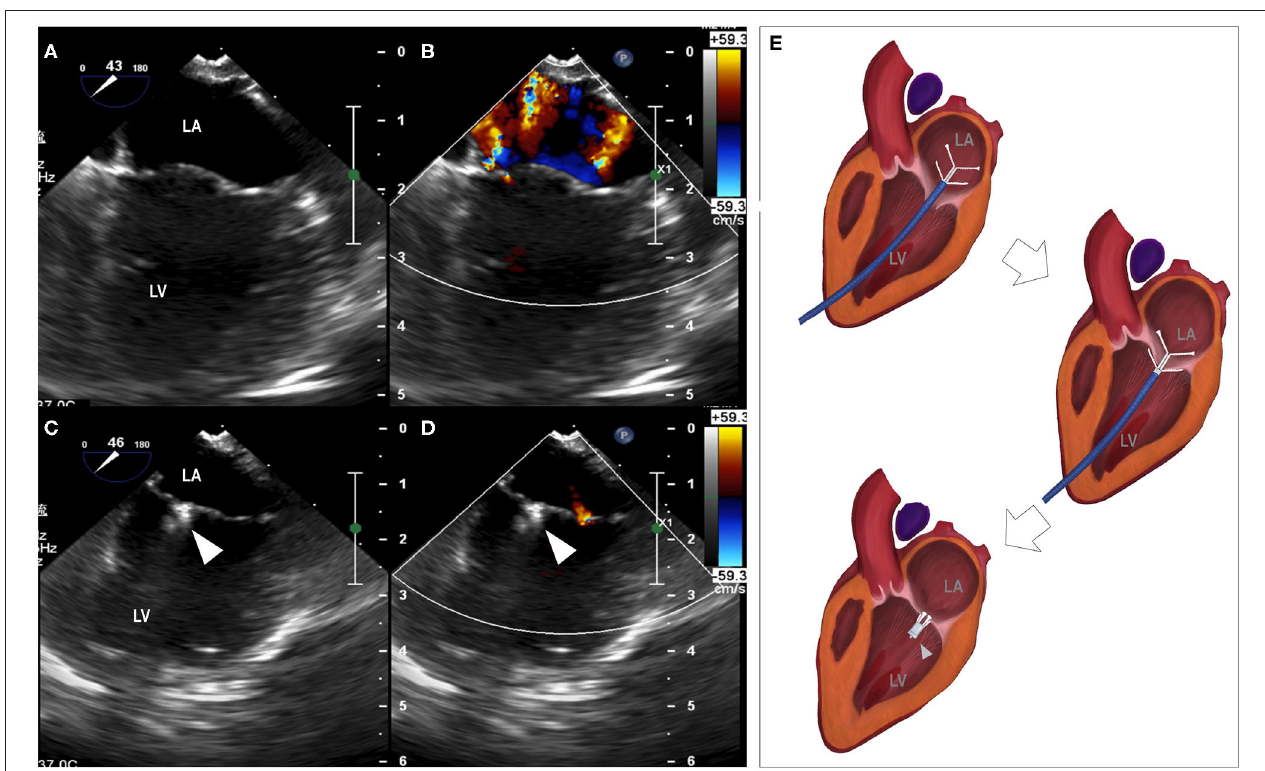
FIGURE 1 | Reduction of mitral regurgitation. (A) median longitudinal view of left atrium and left ventricle before the procedure, (B) mitral regurgitation revealed by color Doppler, (C) median longitudinal view of left atrium and left ventricle with the placement of the clamp, (D) minimal mitral regurgitation detected by color Doppler. (E) Animation of the clamping procedure. LA, left atrium; LV, left ventricle; arrowhead, the